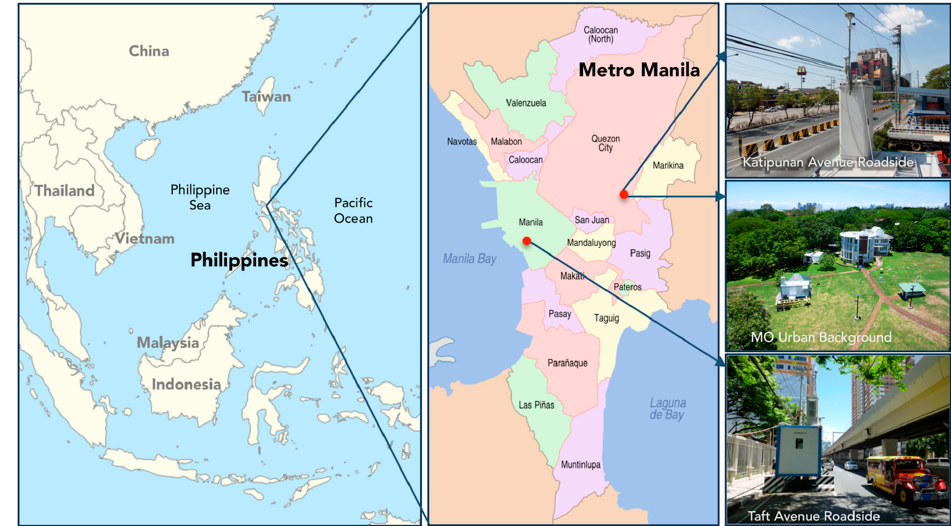
Figure 1. Map of Metro Manila with the approximate locations of the measurement sites during Manila Aerosol Characterization Experiment (MACE) 2015. Data used in this study is from the Taft Avenue Roadside site.